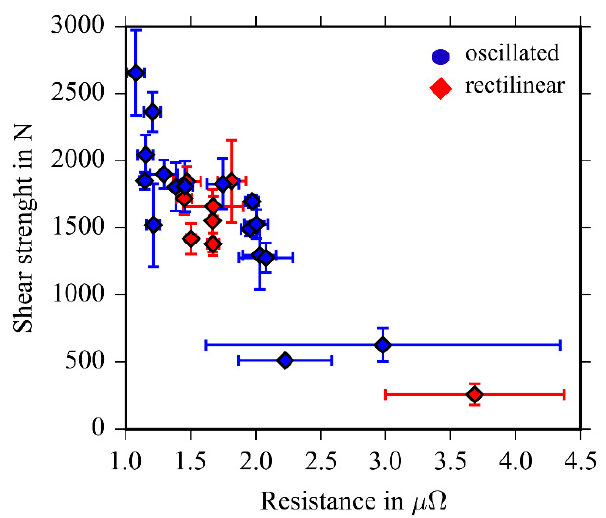
Figure 15. Correlation between electrical resistance and tensile strength for welds produced with (blue markers) and without (red markers) spatial beam oscillation.